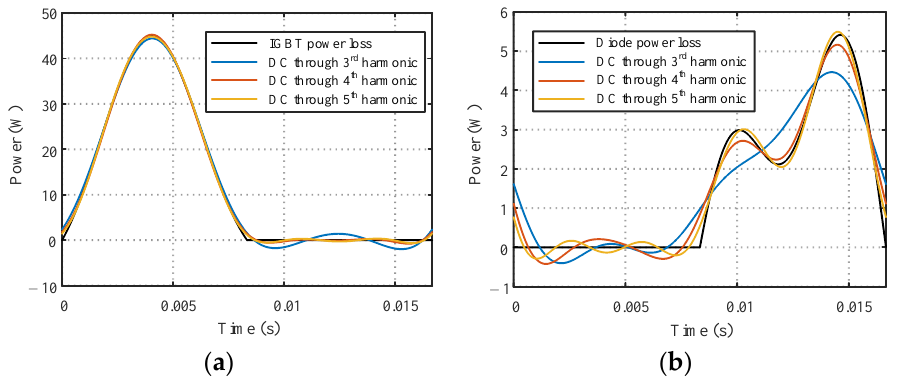
Figure 4. Inverse Fourier transform of ( a ) IGBT power loss and ( b ) diode power loss in a PV inverter. The selected harmonics from the power-loss FFT are then applied to the Foster model of the semiconductors to calculate the corresponding steady-state junction temperature in the frequency domain. The junction temperature phasors are then inversed back to the time domain to determine the junction temperature waveform. A sample of a recovered time-domain junction temperature is shown in Figure